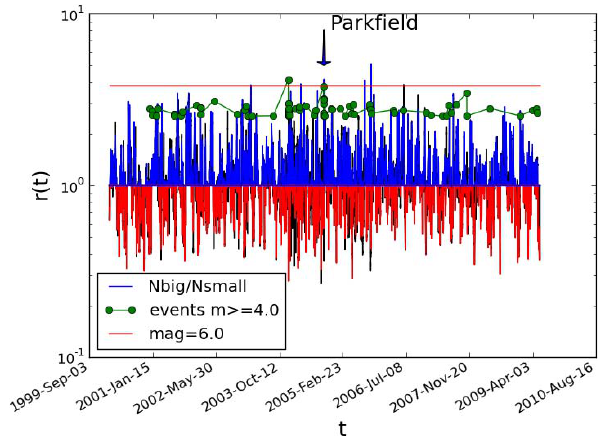
Fig. 9. Same as Fig. 8 but for a 4 ◦ × 4 ◦ region centered on the Park- field